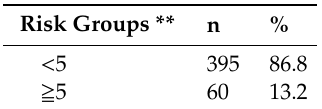
Table 1. Osteoporosis risk groups *.